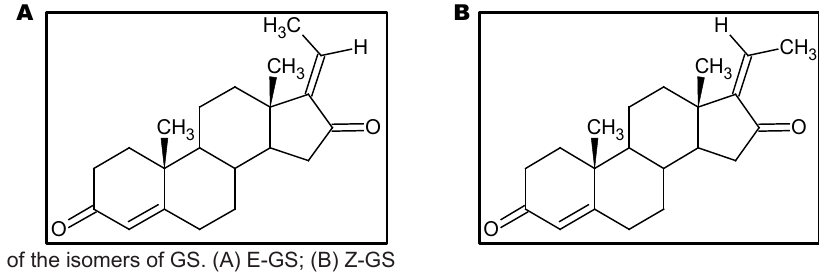
Figure 2. Structures of the isomers of GS. (A) E-GS; (B)